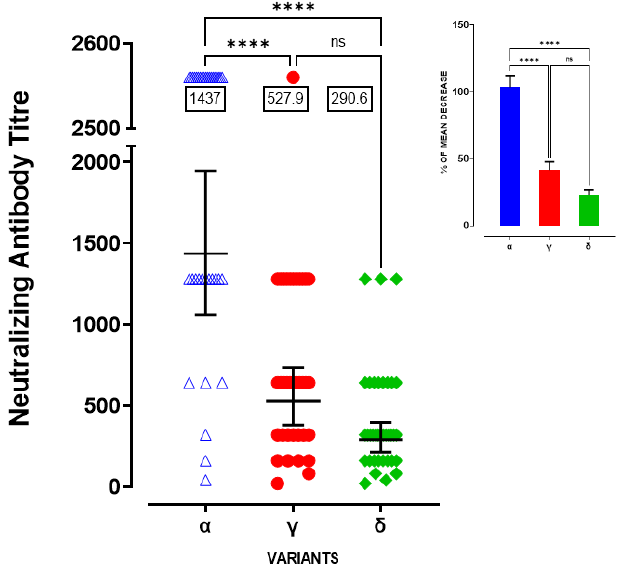
Figure 3. Neutralizing antibody titre against against variants of concern in COVID-19 recovered subjects. Neutralizing antibody titre against Alpha, Gamma and Delta variants in COVID-19 recovered subjects, **** p < 0.0001, ns = not significant; Inset: Percentage (%) of mean decrease for neutralizing antibody titre against Gamma and Delta variants with respect to Alpha **** p < 0.0001, ns = not